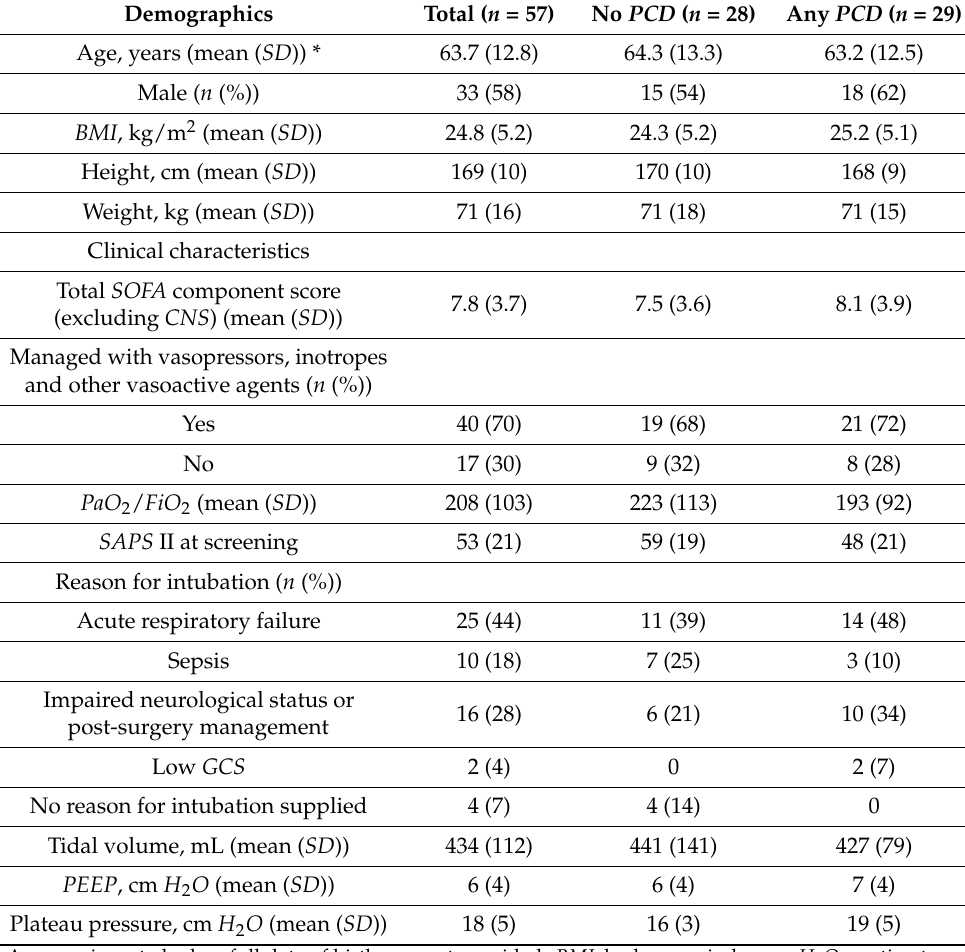
Table 1. Participant demographics and clinical characteristics at